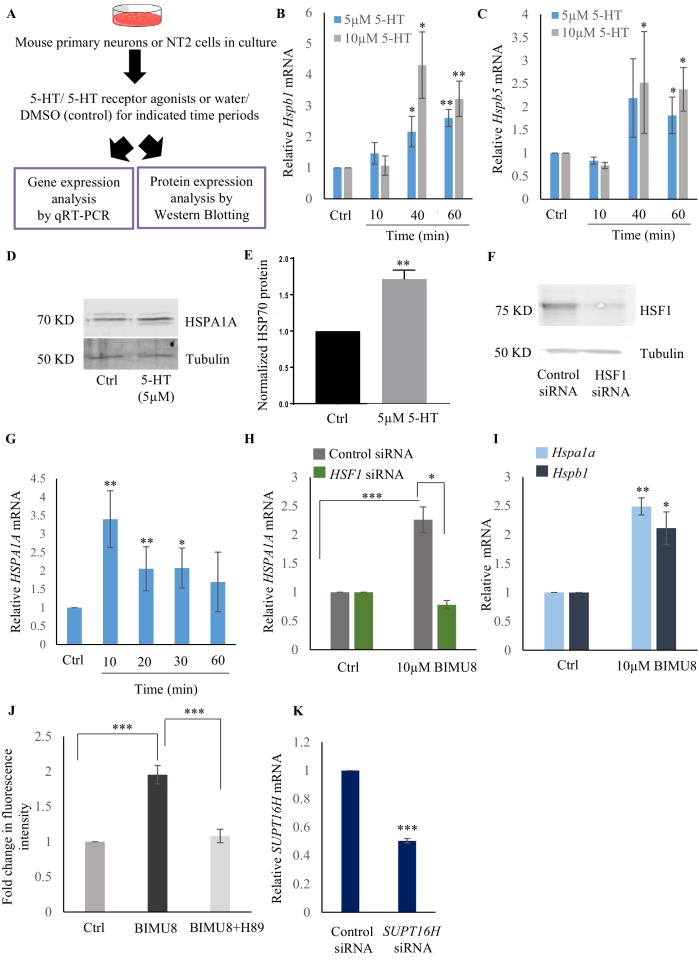
Serotonin activates a PKA-mediated signal transduction pathway to enable HSF1-FACT interaction in mammalian cells.(A) Experimental setup for assessing whether 5-HT is a conserved signal that activates HSF1 in mammalian cells. (B, C) Time and dose-dependent change in Hspb1 and Hspb5 mRNA levels respectively, in control and 5-HT-treated primary cortical neuronal cultures (n = 4 experiments). (D) Representative western blot showing HSPA1A protein levels following 5-HT stimulation of NT2 cells (5 µM was applied for 24 hr to be able to assess protein accumulation; n = 4 experiments). (E) Quantitation of HSPA1A protein levels in control and 5-HT treated NT2 cells (n = 3 experiments). Tubulin was used as internal control. (F) Representative western blot showing HSF1 protein levels in control and HSF1 siRNA-treated NT2 cells to confirm siRNA knockdown of HSF1 (n = 2 experiments). (G) Temporal dynamics of HSPA1A mRNA levels in control and BIMU8-treated NT2 cells (n = 5 experiments). (H) HSPA1A mRNA levels in untreated and BIMU8-treated NT2 cells (10 µM for 10 min) transfected with control and HSF-1 siRNA (n = 4 experiments). (I) Hspa1 and Hspb1 mRNA levels in untreated and BIMU8-treated (10 µM for 10 min) primary cortical neuronal cultures (n = 3 experiments). (J) Quantitation of fluorescence intensity following immunostaining for HSF1 in the nuclei of untreated NT2 cells, NT2 cells treated with BIMU8 (10 µM for 10 min), and NT2 cells treated with BIMU8 and H89. Fluorescence intensity values (arbitrary units) were derived using ImageJ following background subtraction and normalized to that in control untreated cells. (n = 2 experiments; 25 cells each). (K) SUPT16H mRNA levels in control-siRNA and SUPT16H-siRNA treated NT2 cells to confirm siRNA knockdown of SUPT16H (n = 5 experiments). Data in B, C, E, G-K show Mean ± Standard Error of the Mean. Values were normalized to that in either control untreated cells, or control-siRNA treated cells. *, p<0.05; **, p<0.01 ***, p<0.001; (paired Students t-test).